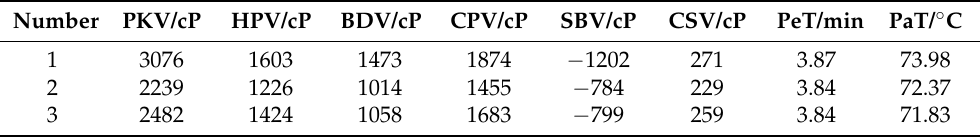
Table 3. The Rapid Visco Analyzer spectrum values of the 29 glutinous rice varieties. Number